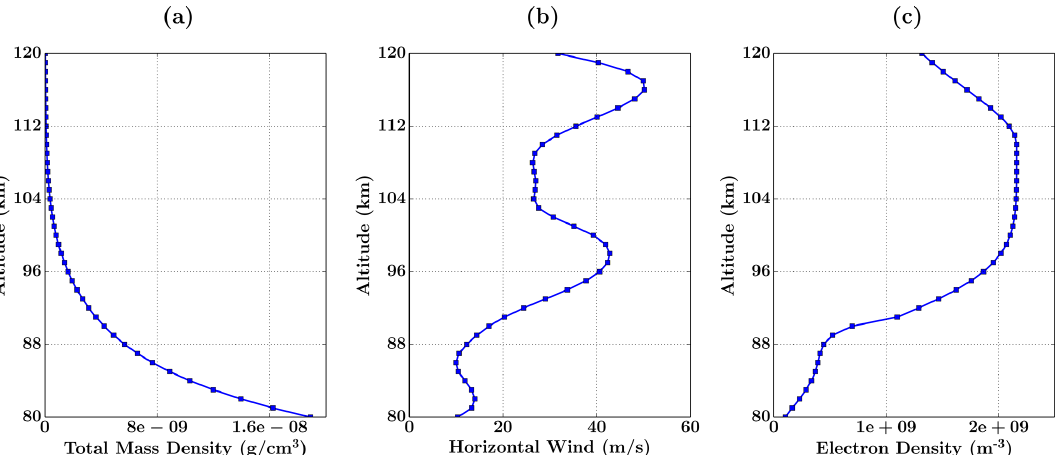
Figure 2. Corresponding atmospheric properties used to simulate the non-specular meteor echo shown in Fig. 1. (a) Background neutral density, (b) horizontal wind speeds, and (c) background electron